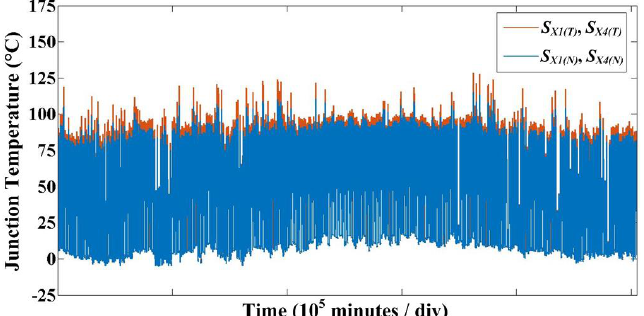
Figure 11. Junction temperature profiles of the outer IGBTs of the NPC inverter and half-bridge IGBTs of the T-type